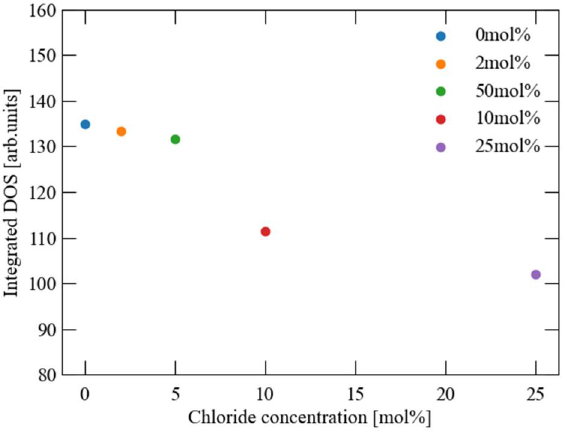
Figure 2. Integrated density of states in CH 3 NH 3 Pb(Cl,I) 3 as a function of Cl concentration.